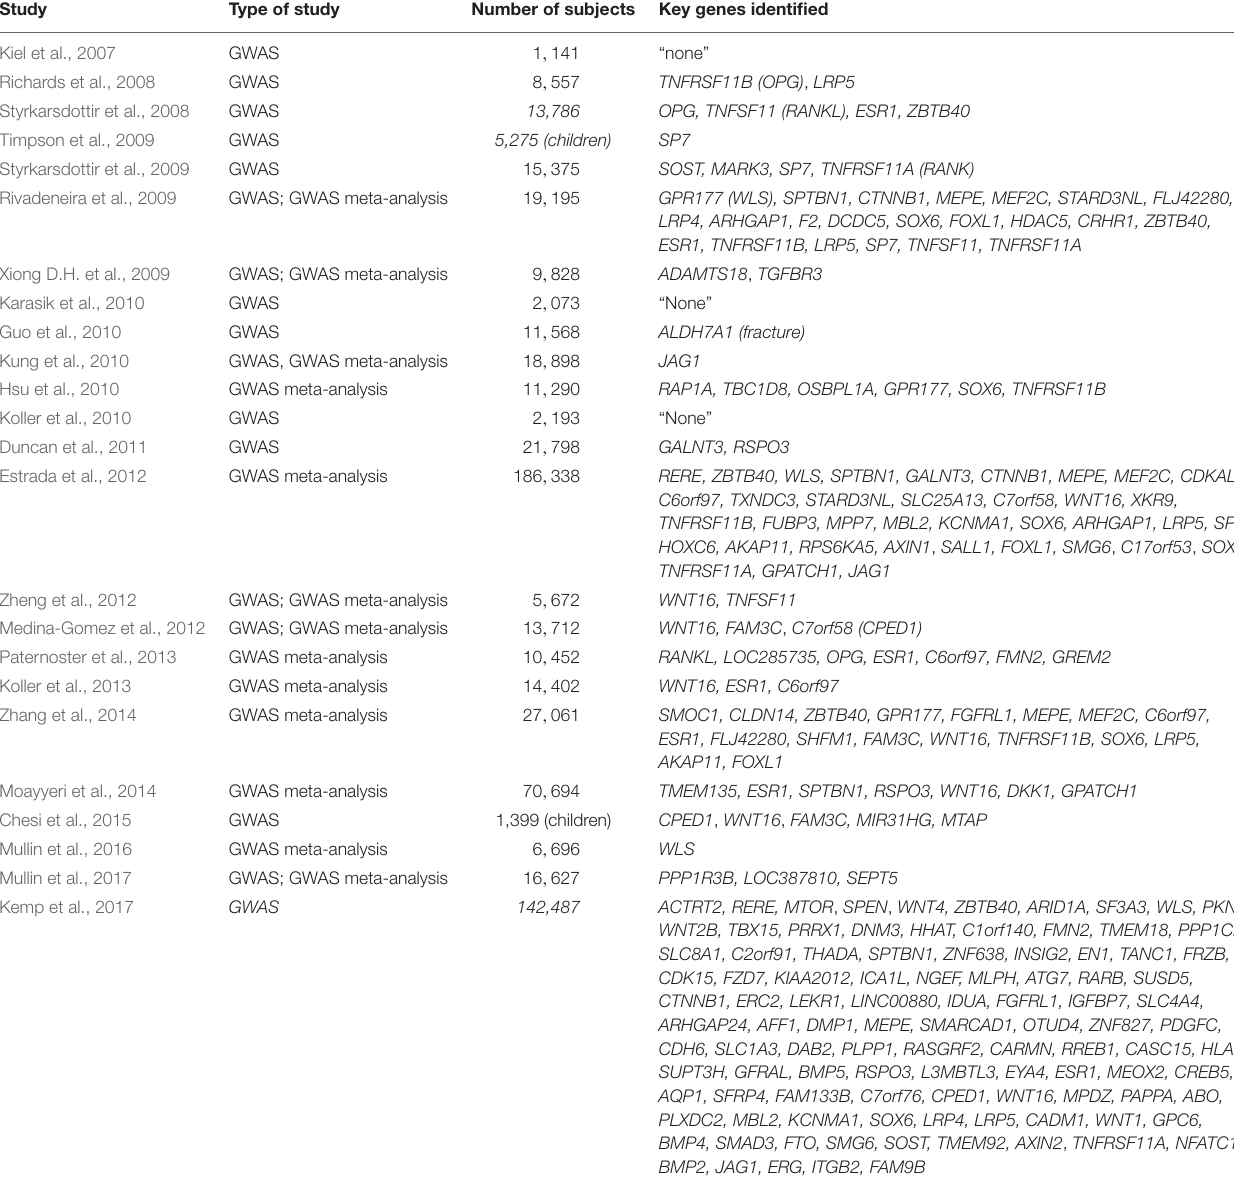
TABLE 1 | Genes with genome-wide significant evidence for association with BMD and